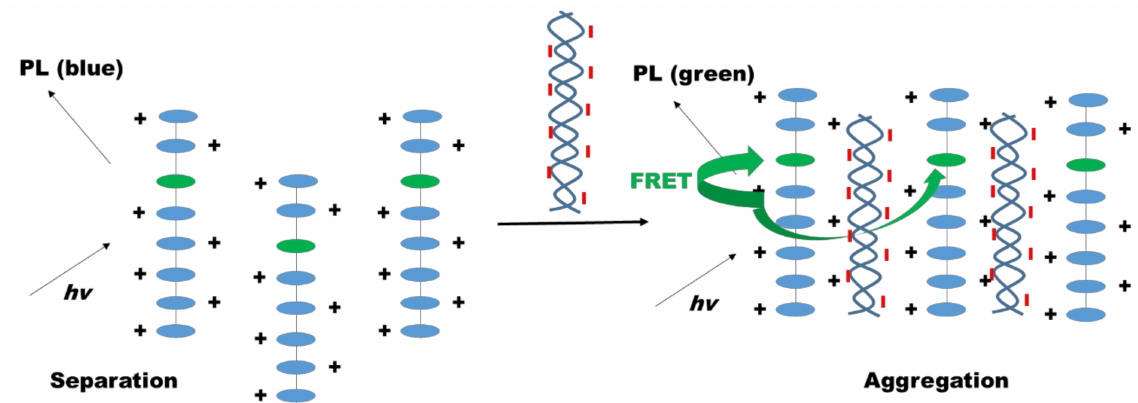
Figure 31. Schematic representation of the fluorescent resonance energy transfer (FRET) of the water-soluble electrolyte by addition of DNA. Adapted from